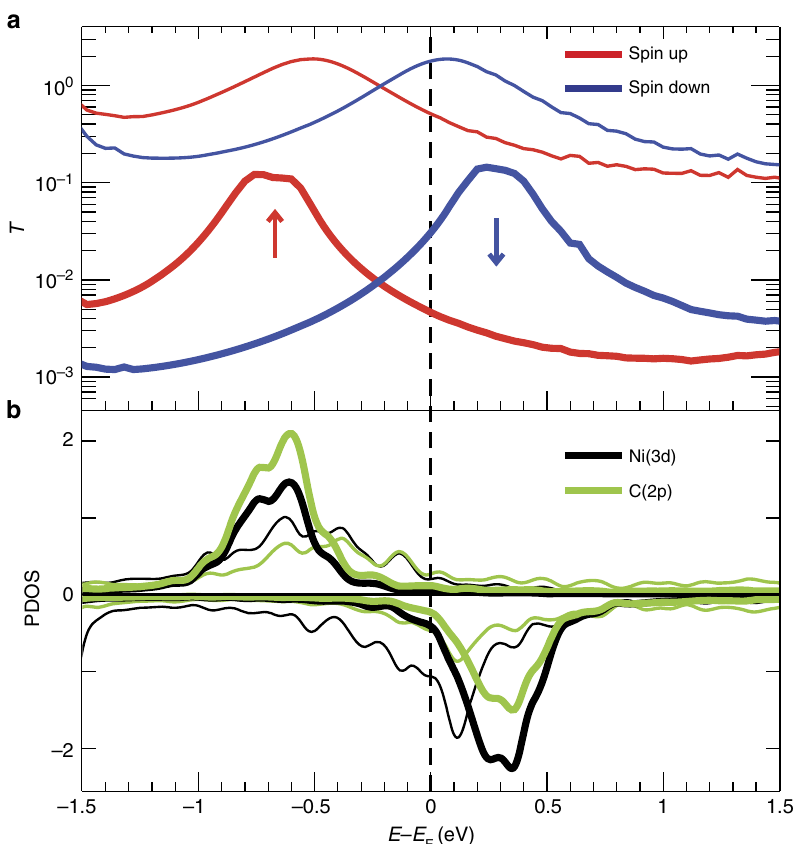
Fig. 4 Transmission and PDOS of the molecular junction. a Spin-resolved electron transmission as a function of electron energy with respect to the Fermi energy for the Nc-tip above Cu(100). The thick line corresponds to the tunneling con fi guration (Fig. 3c) and the thin line to the contact con fi guration (Fig. 3d). b Density of states projected (PDOS) onto the C(2p) and Ni(3d) atomic orbitals for the tunneling (thick line) and for the contact (thin line) regimes. A comparison between SIESTA and VASP results can be found in Supplementary Fig.